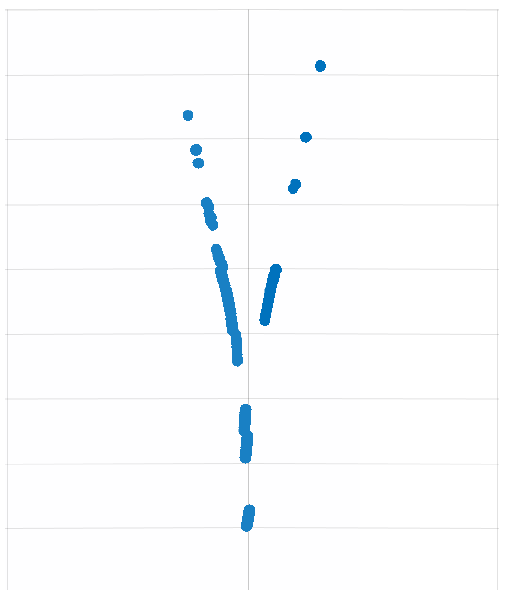
Figure 3. Poincaré map corresponding to the intersection of the phase space with the surface Σ